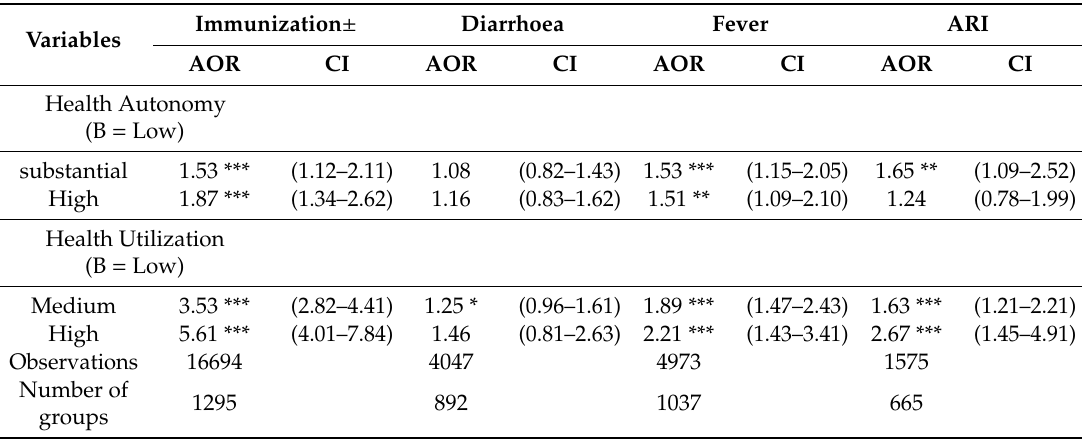
Figure A1. The trends of immunization status and treatment for morbidities among children less than three years | ARI = Acute respiratory infection. Table A1. Adjusted odds ratio from multilevel logistic regression on preventive and curative infant and child health in Nigeria